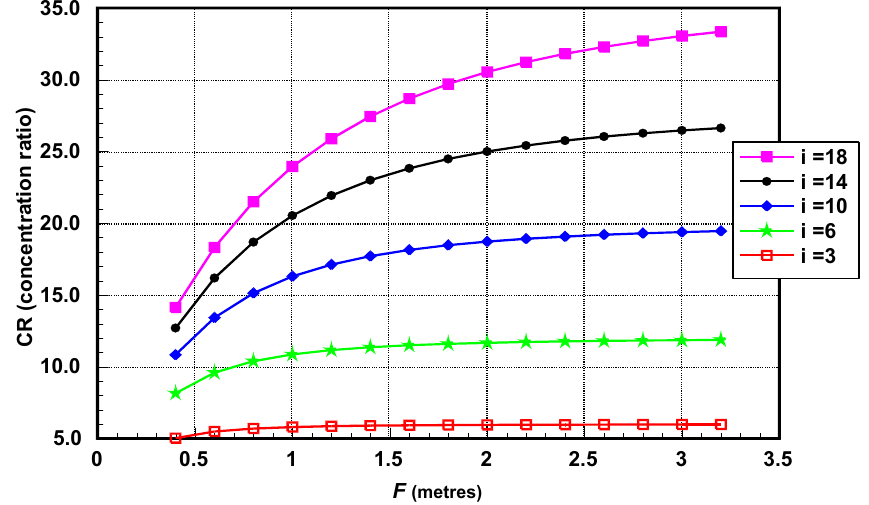
Figure 6. Variations in the concentration ratio plotted against focuses distance for different number of mirrors of a concentrator aperture, absorber width a = 0.125 m.